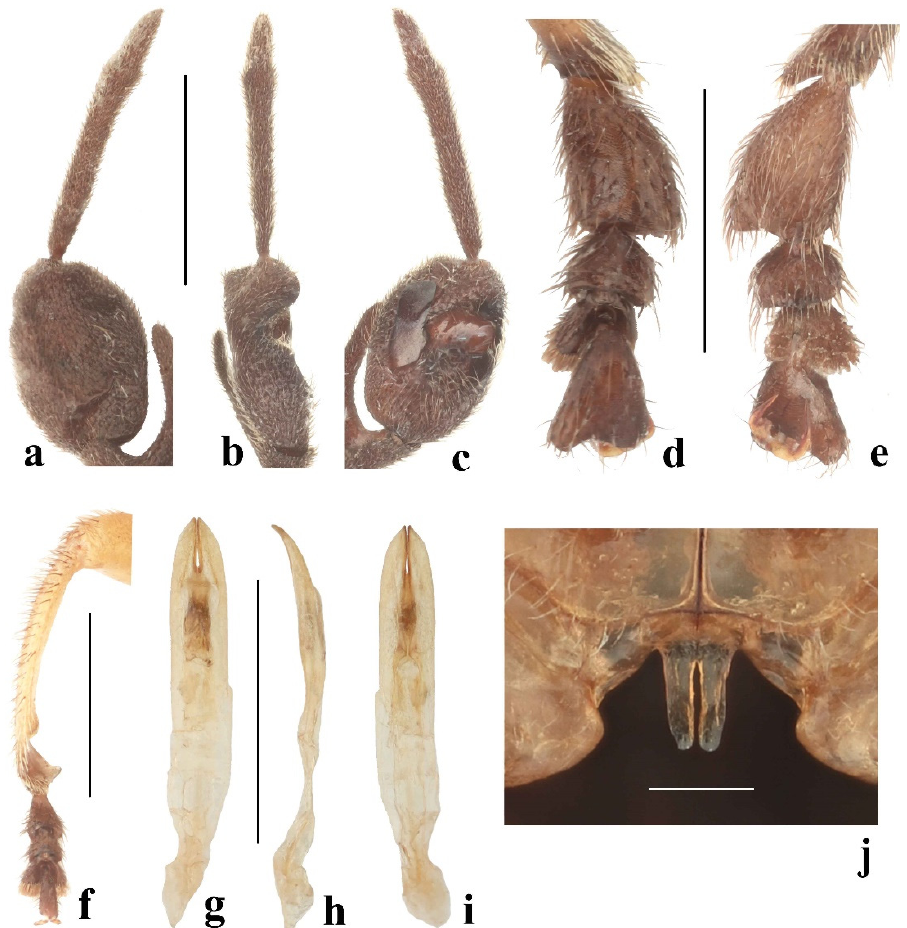
Figure 15. Taumacera maskeliya sp. nov.: ( a ) antennomeres X–XII, dorsal view; ( b ) antennomeres X– XII, lateral view; ( c ) antennomeres X–XII, ventral view; ( d ) metatarsus, dorsal view; ( e ) metatarsus, ventral view; ( f ) mesotibia; ( g ) aedeagus, dorsal view; ( h ) aedeagus, lateral view; ( i ) aedeagus, ventral view; ( j ) metasternal process. (Scale bars: ( a – i ) = 1 mm, ( j ) = 0.3 mm). Female unknown.